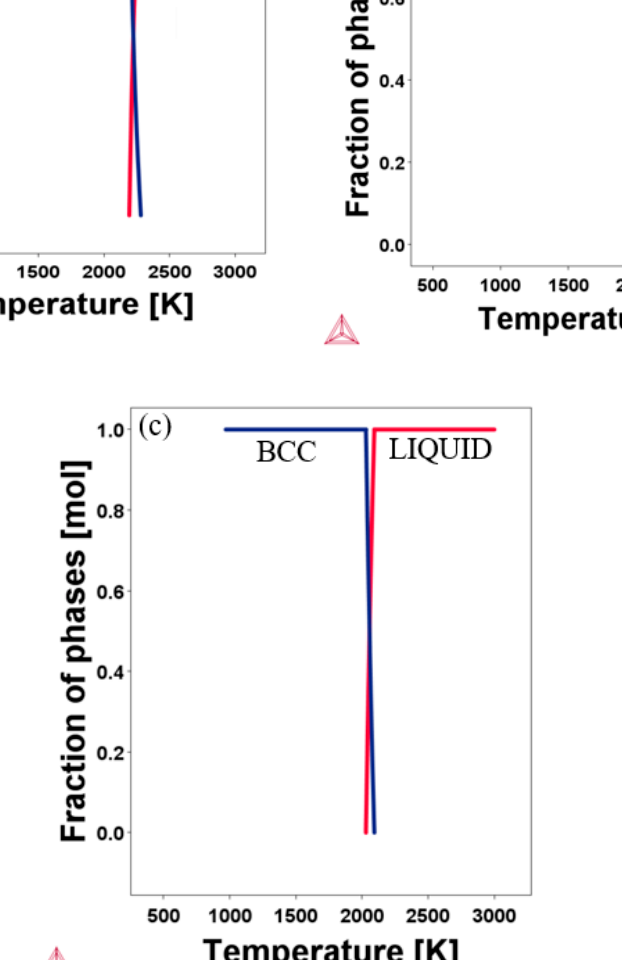
Table 2. Calculated three independent elastic constants (GPa); 𝐶 (cid:2869)(cid:2869) ; 𝐶 (cid:2869)(cid:2870) ; 𝐶 (cid:2872)(cid:2872) , Cauchy pressure 𝐶 (cid:2869)(cid:2869)(cid:2879) 𝐶 (cid:2872)(cid:2872) (GPa), bulk modulus B (GPa), shear modulus G (GPa), Young’s modulus E (GPa), Poisson's ratio ( ν ), Pugh’s ratio ( B/G ), lattice constant a ( Å ), density ρ (gm/cm 3 ) and hardness H v (GPa) at zero pressure and Kelvin, respectively.